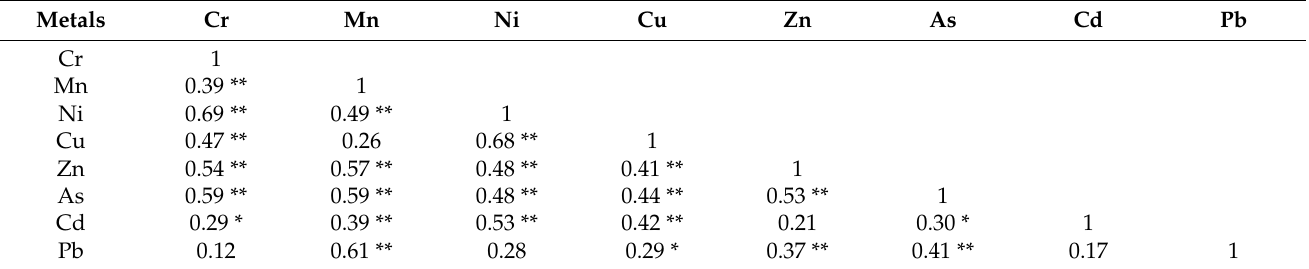
Table 2. Spearmen’s rank correlations between metals in hand